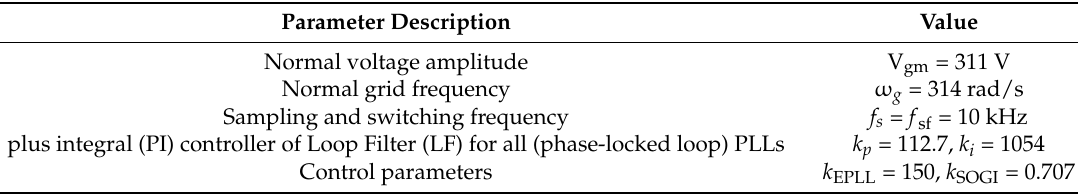
Table 1. Parameters of the PLL system in the single-phase grid-connected